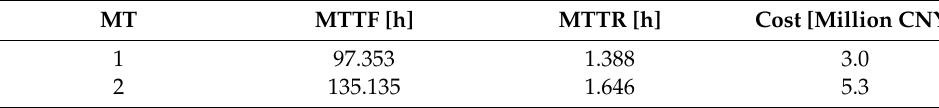
Table A3. Considered machine tool (MT) parameters.